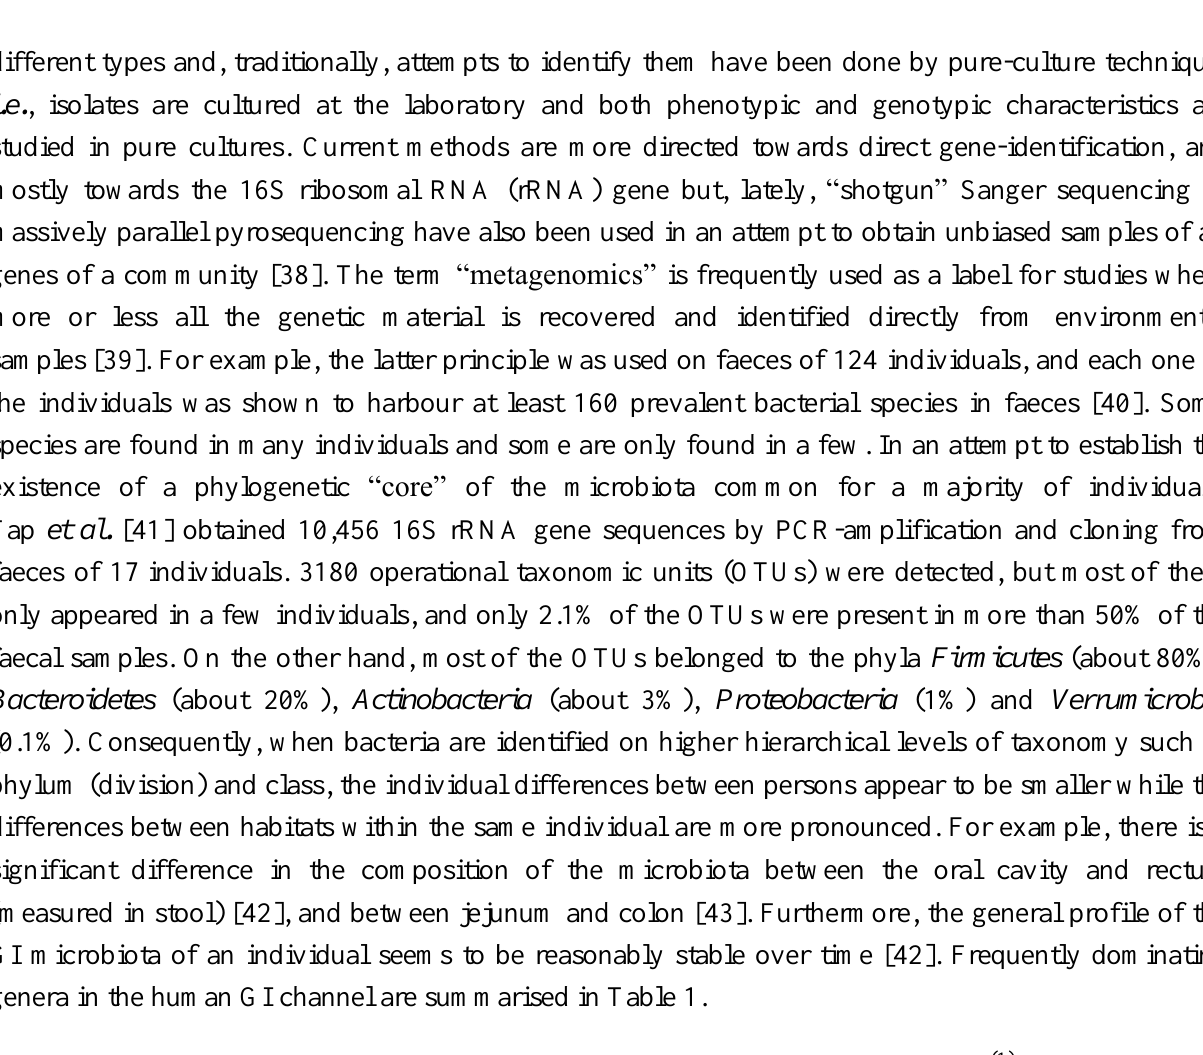
Table 1. Taxa dominating the bacterial microbiota of the GI-tract (1)